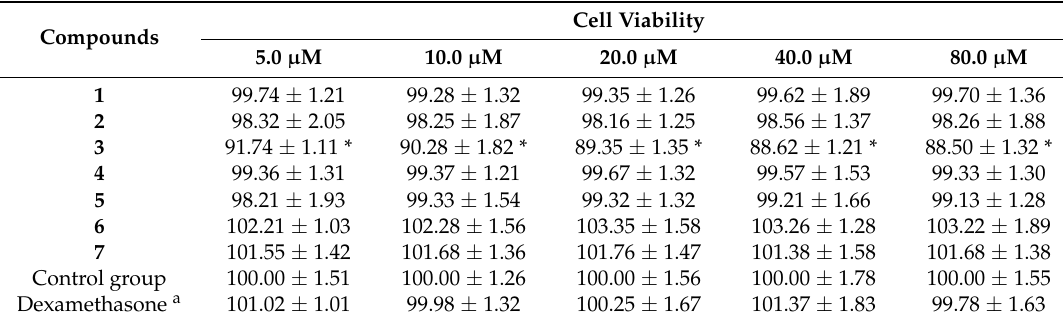
Table 4. The cytotoxic activity of compounds on BV2 microglial cells ( n = 3).